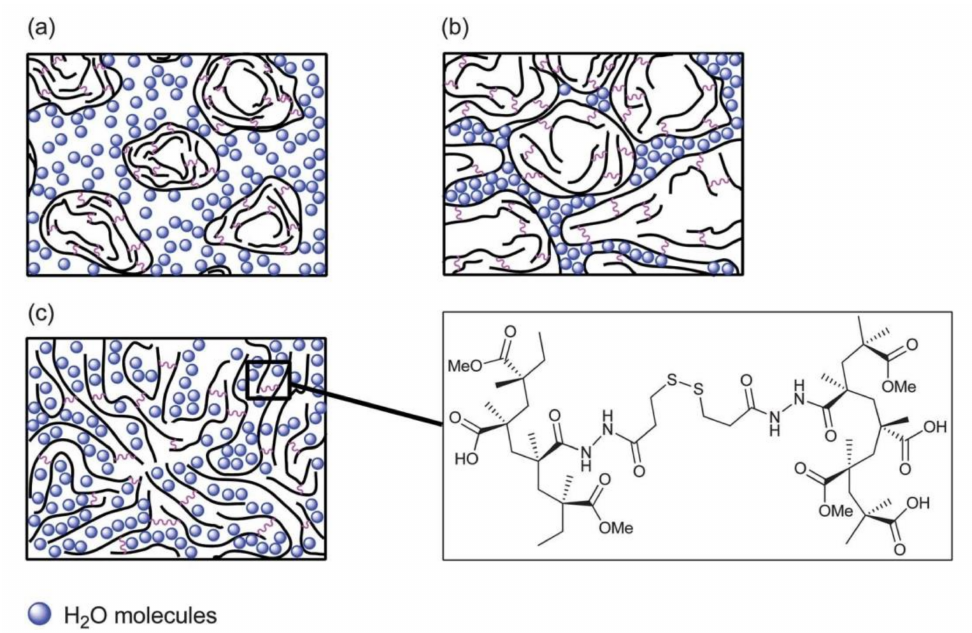
Figure 6. ( a ) Representation of polystyrene-methacrylic acid (PMMA-MAA)- and phenethylamine- methacrylic acid (PEA-MAA)-crosslinked particles in a non-swollen state at pH < 6.5–7.0; ( b ) PMMA- MAA- and PEA-MAA-crosslinked particles in the swollen state at physiological pH; ( c ) gelation of PMMA-MAA/DTP-crosslinked particles at a pH of 6.5–7.0. Reprinted with permission from Ref. [87]. Copyright 2013, Halacheva,